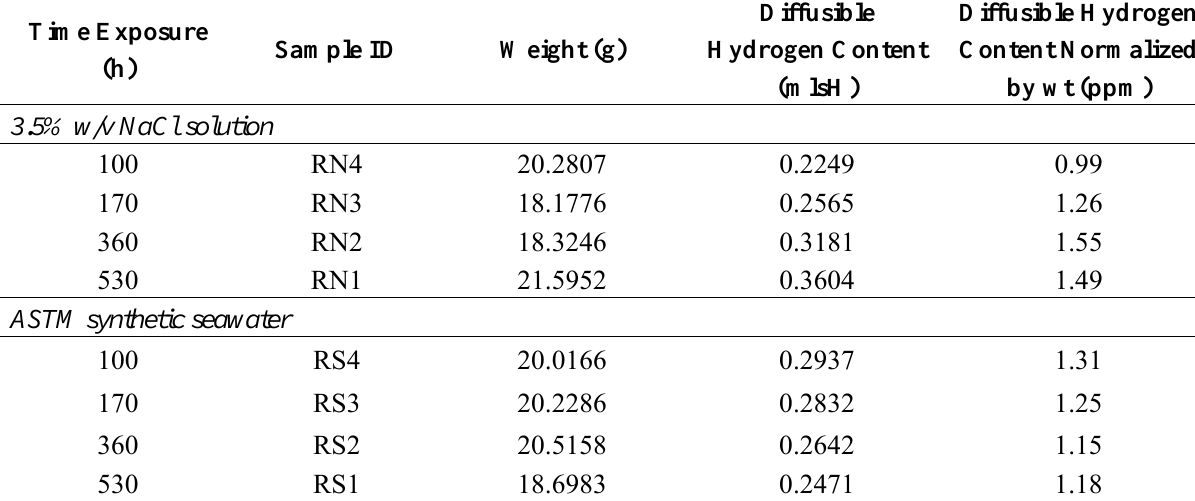
Table 2. Diffusible hydrogen